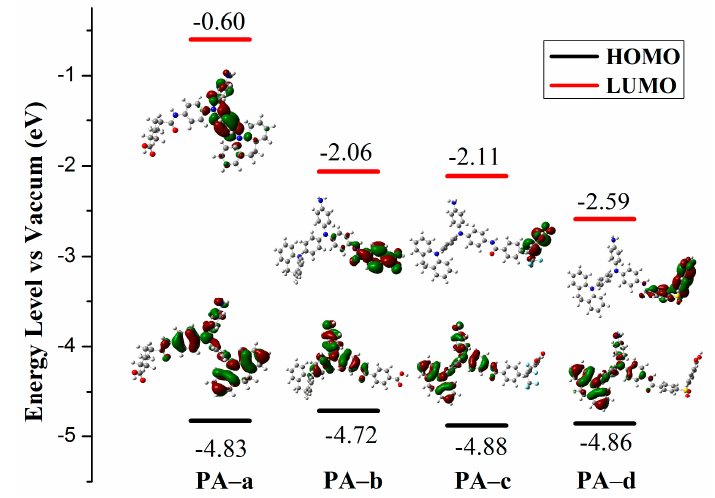
Figure 4. The frontier molecular orbitals computed for PAs at the B3LYP/6-31G.